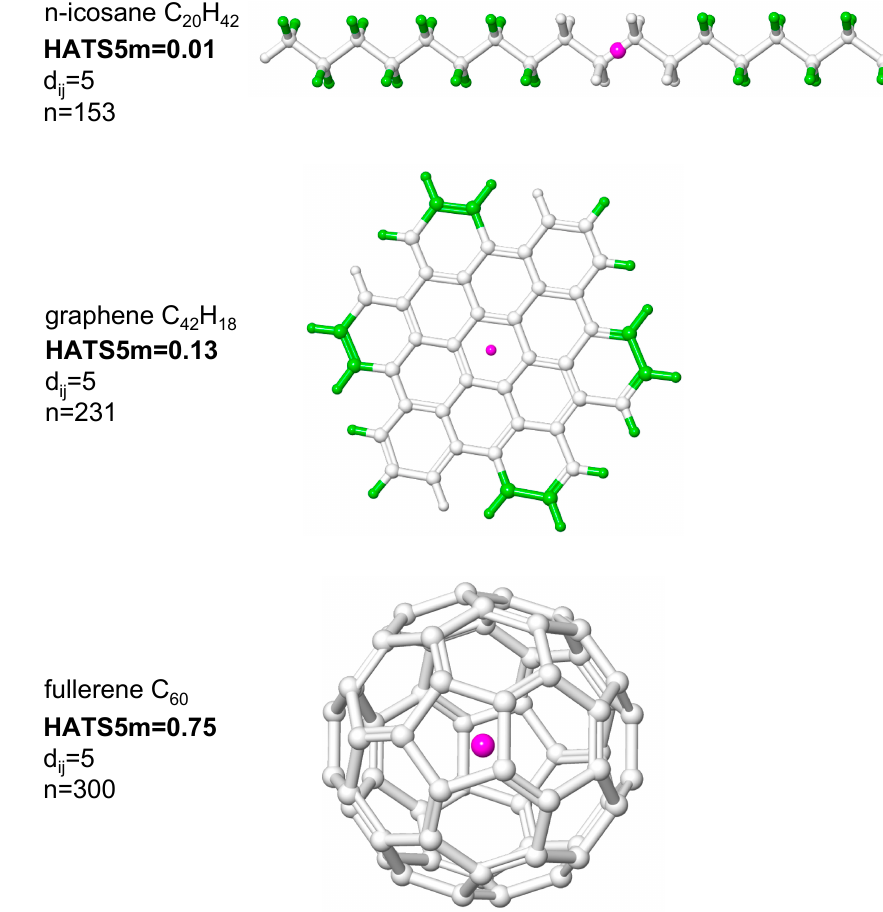
Figure 2. HATS5m values for molecules with various shapes: n ‐ icosane C 20 H 42 , fullerene C 60 , and graphene ‐ like structure C 42 H 18 ; d ij —the topological distance between the i th and j th atoms; n—number of atomic pairs spaced at d ij distance. Atoms with the highest value of leverage are depicted in green. The geometric center of the molecule is marked pink.